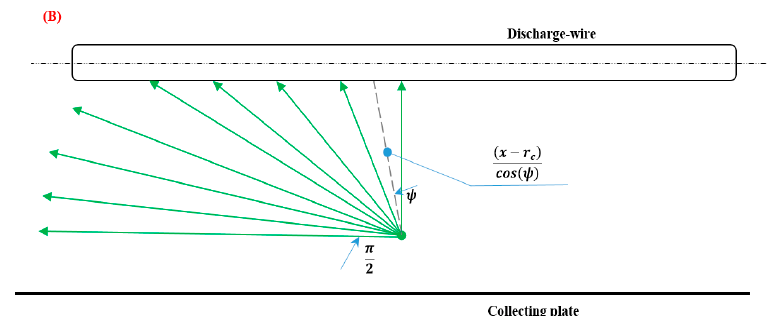
Figure A1. Schematic diagram of the geometry factor g ( x ) of discharge wires of WDESP: ( A ) radial and ( B ) axial components.